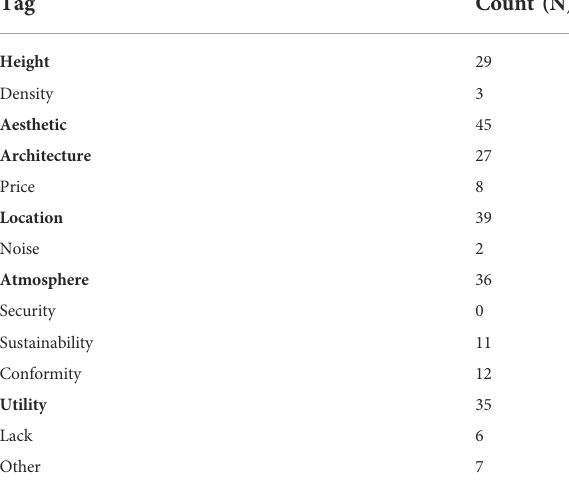
TABLE 2 Assessment of the tags recorded by the